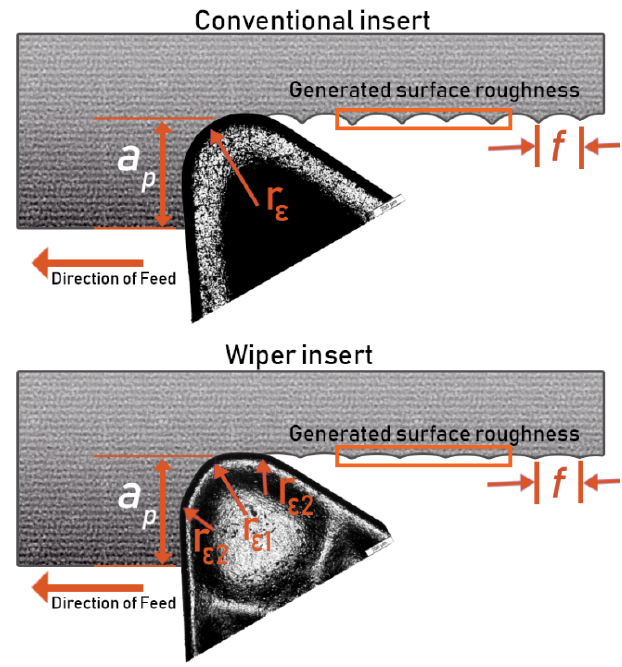
Figure 1. Machining action of ( a ) conventional and ( b ) wiper inserts.